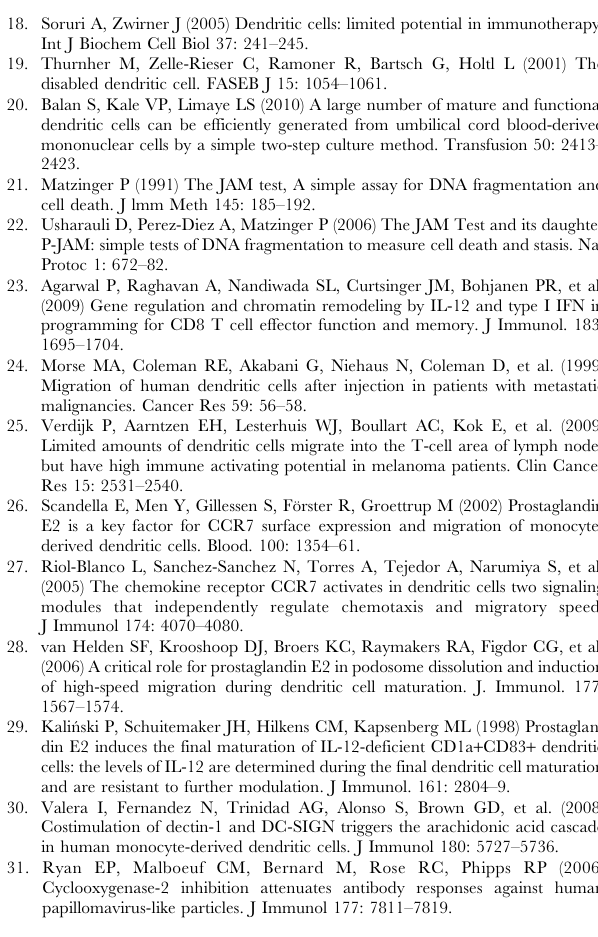
Figure S3 AA + DCs and AA - DCs show similar morphol- ogy. Phase contrast images of (A) Immature adhered DCs. (B) Both cultures show the typical veiled clusters of mature DCs. (C) Wright-Giemsa images of adherent cells show typical DC morphology. Original magnification for A is 10X, for B and C is 20X. The phase contrast images were cropped and enlarged. (TIF) Figure S4 IL-12 p70/IL-10 ratio was higher in AA + DCs as compared to AA - DCs. Concentrations of IL-12 p70 and IL- 10 was in pg/ml. (TIF) Figure S5 CTL assay of other two samples showing improved killing in AA + DCs.